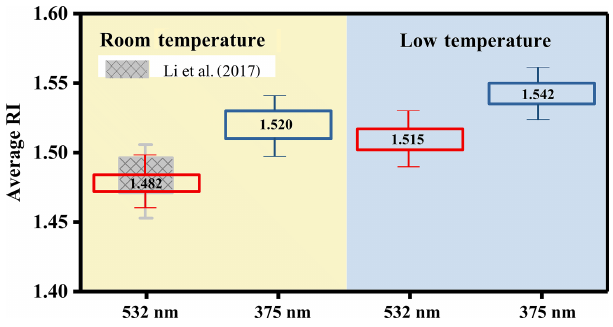
Figure 1. Summary of the averaged RI values of n -dodecane SOA at room temperature (25 ◦ C; the light orange area) and under low- temperature conditions (5 ◦ C; the light blue area) at wavelengths of 532 and 375nm. The red box is the averaged RI value for n - dodecane at 532nm, the shaded boxes are the RI values from our previous study at 532nm (Li et al., 2017a) and the blue box is the averaged RI value for n -dodecane at 375nm.